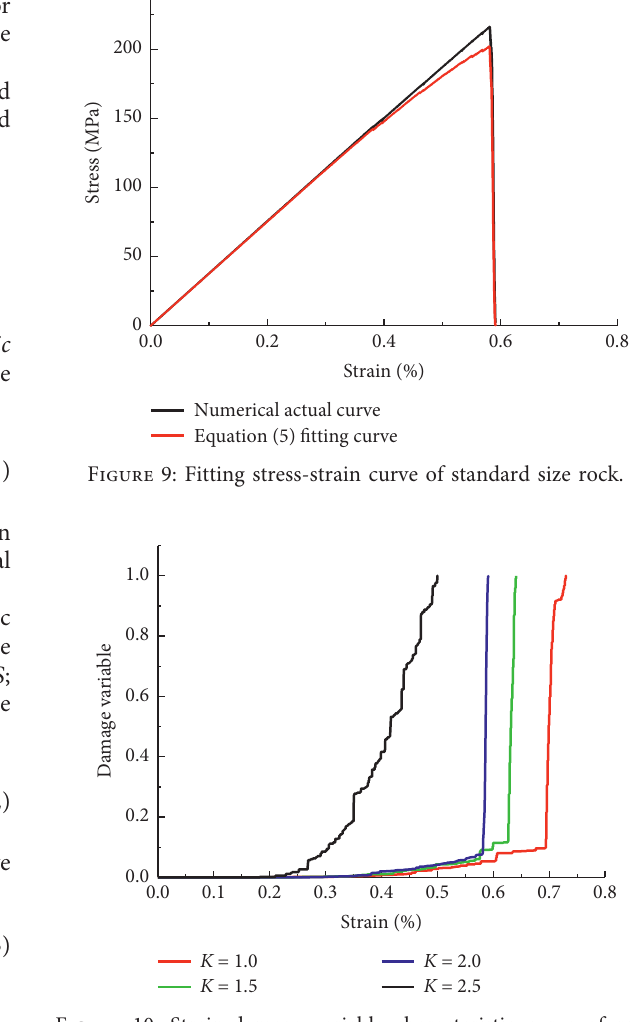
Figure 10: Strain-damage variable characteristic curve of rock numerical